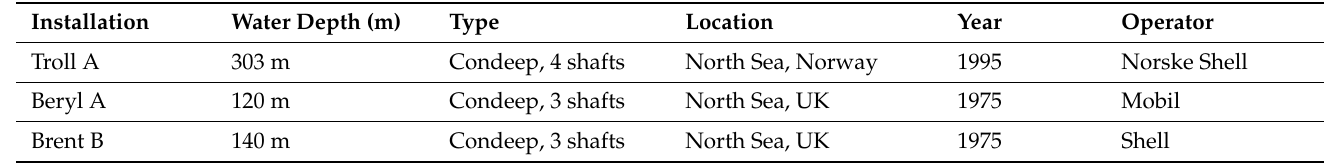
Table 12. Installation of different concrete gravity-based